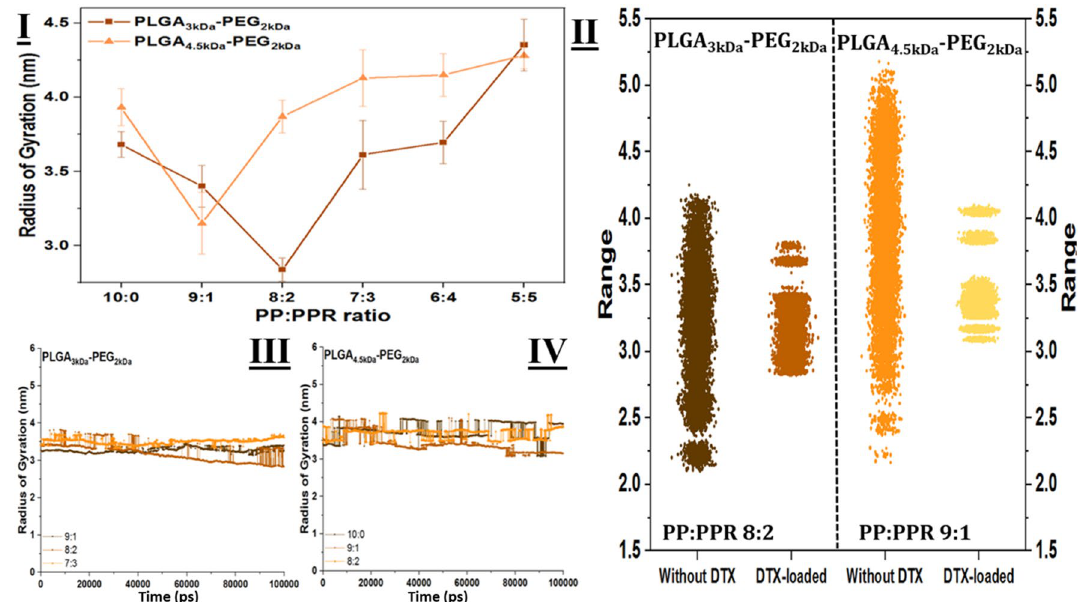
Figure 3. Gyration radius of nanoparticles. ( I ) Final R g of NPs based on PLGA3 kDa-PEG2 kDa and from PLGA4.5 kDa-PEG2 kDa in the combination with varying ratios of PLGA4.5 kDa-PEG2 kDa-RF in the composition. As is clear, stability changes depending on the molecular composition of repeating monomers in the structure of the basic polymer strand. ( II ) The addition of DTX molecules to the NPs affects the fluctuations of NPs during assembly. ( III ) and ( IV ) R g fluctuations for drug-loaded RF-conjugated NPs vs. time reveals the stability and lower range of